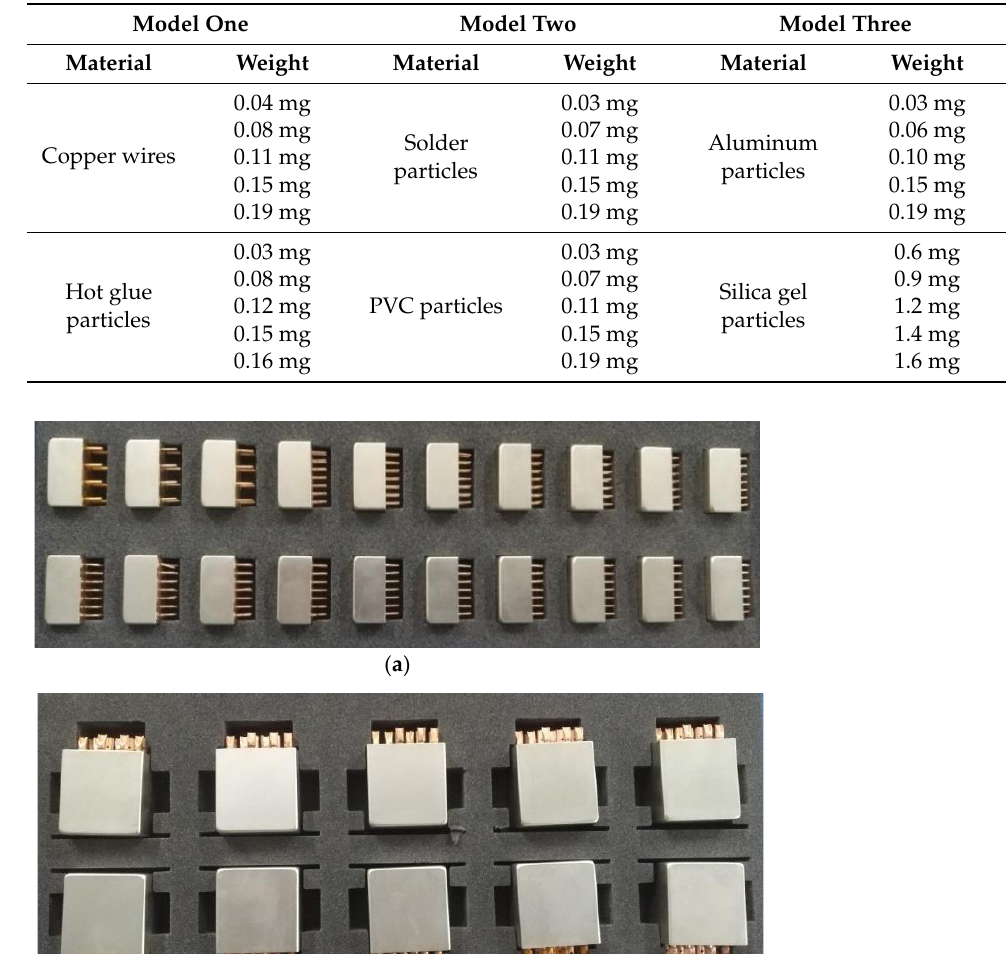
Table 1. Model of the sealed relay samples, material information, and weight information about the contained loose particles.